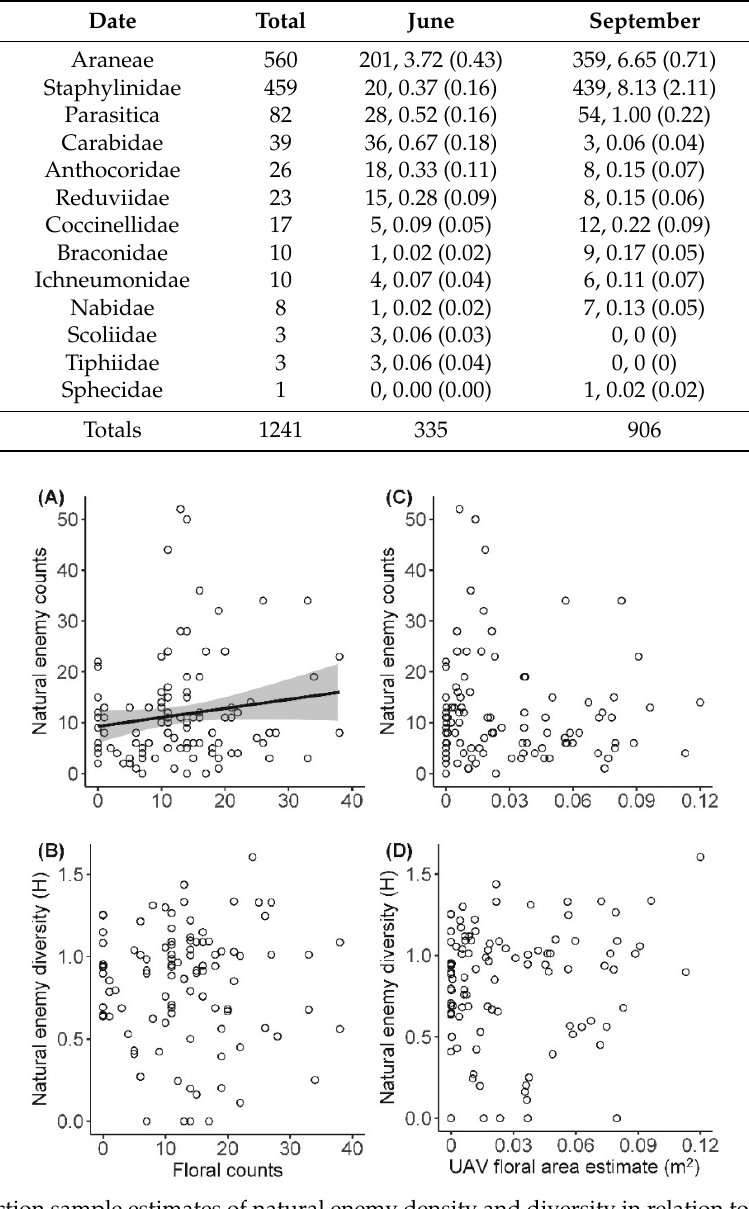
Figure 4. Suction sample estimates of natural enemy density and diversity in relation to visual floral counts within 0.25 m 2 quadrats ( A , B ), and UAV—estimated floral area within the quadrats ( C , D ). For ease of interpretation, the line represents the linear relationship between untransformed floral counts, with the shaded area indicating 95% confidence intervals (see Table 2).